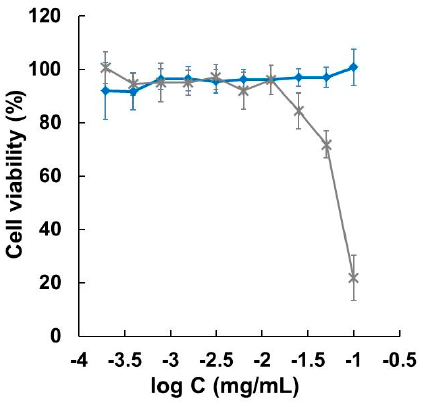
Figure 5. Viability of L929 cells after 24 h incubation as a function of concentrations of ( (cid:31) ) EI 4 /Gal-Dex- g -SS-OLA nanogels and ( × ) SDS.